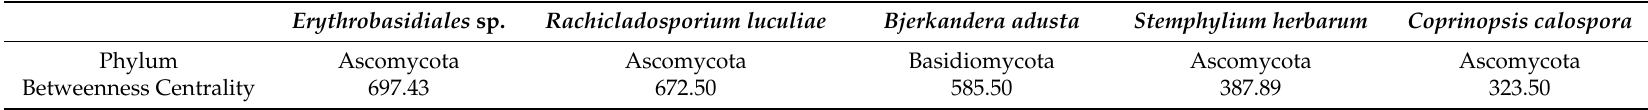
Table 3. Dominant keystone species from four native